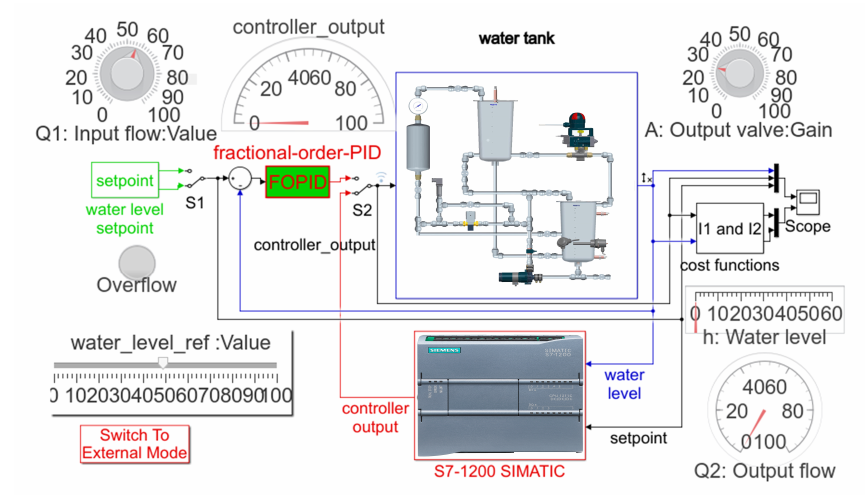
Figure 3. Simulink simulator of the PLC water level control system. FOPID, fractional-order proportional-integral-derivative.